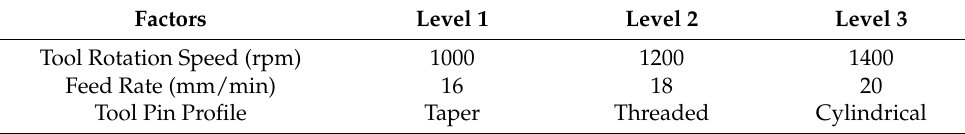
Table 2. Input parameters are involved along with their